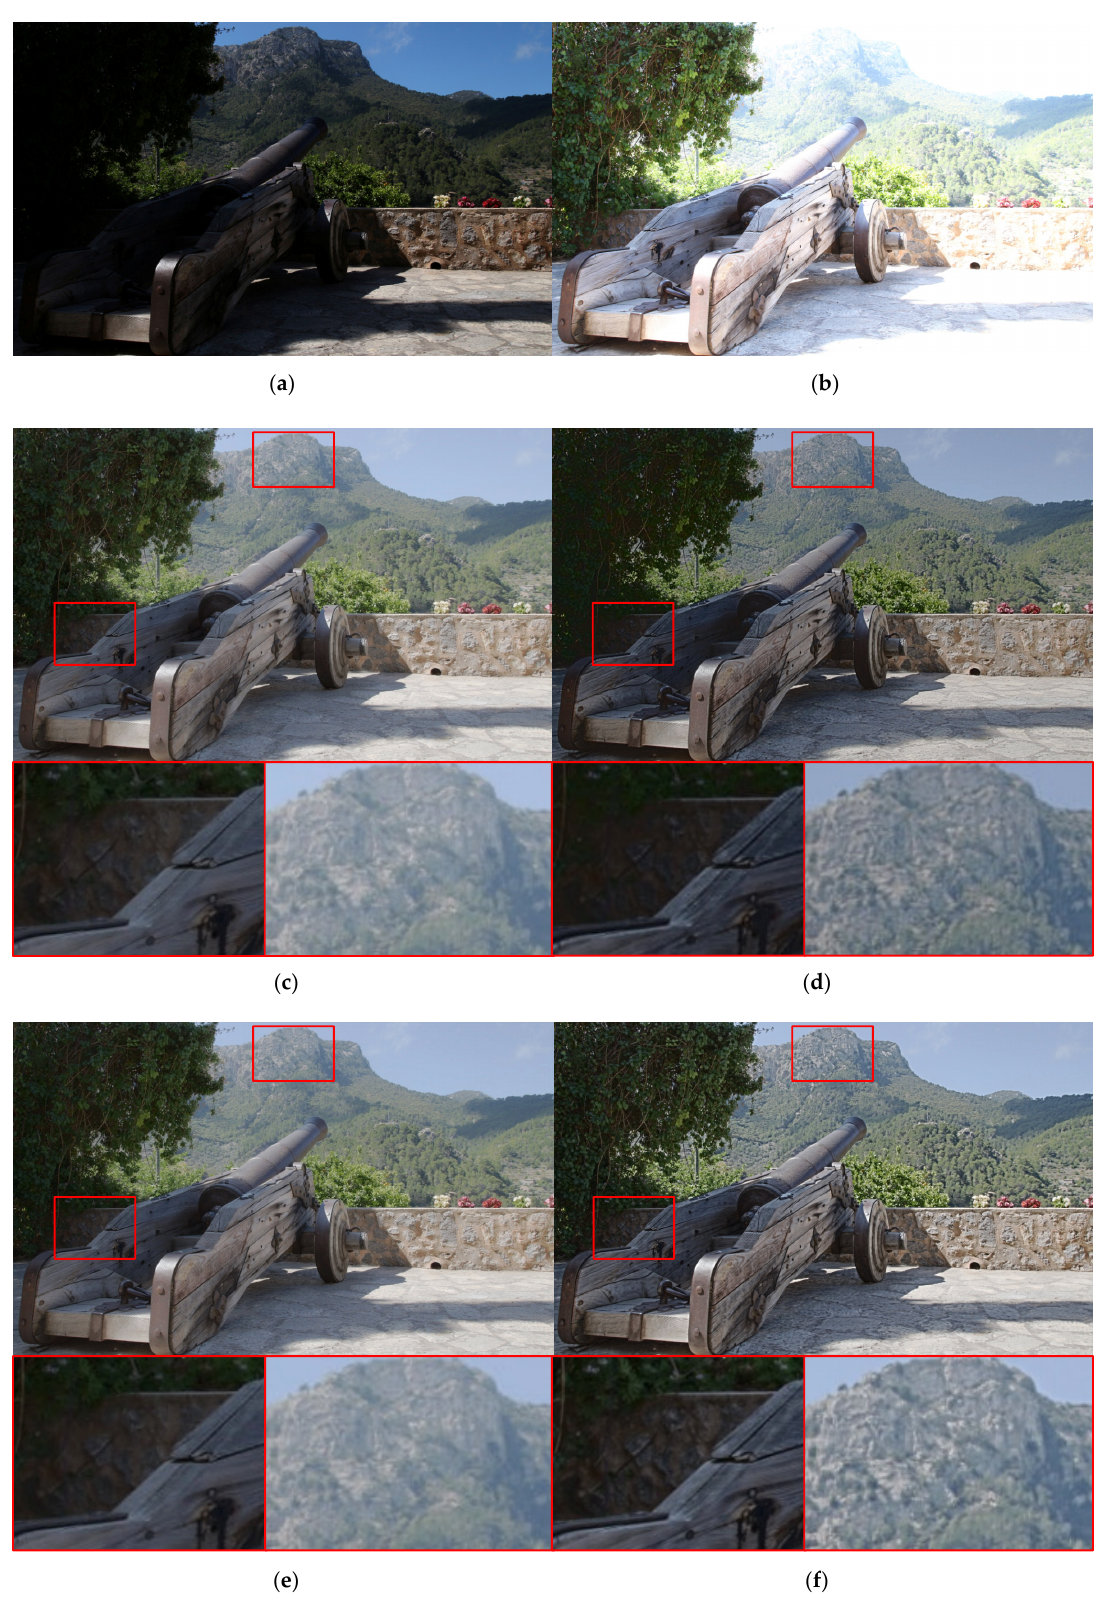
Figure 16. Input and result images (6): ( a ) Under-exposed image, ( b ) Over-exposed image, ( c ) DenseFuse, ( d ) U2Fusion, ( e ) TransMEF, ( f ) Proposed model.